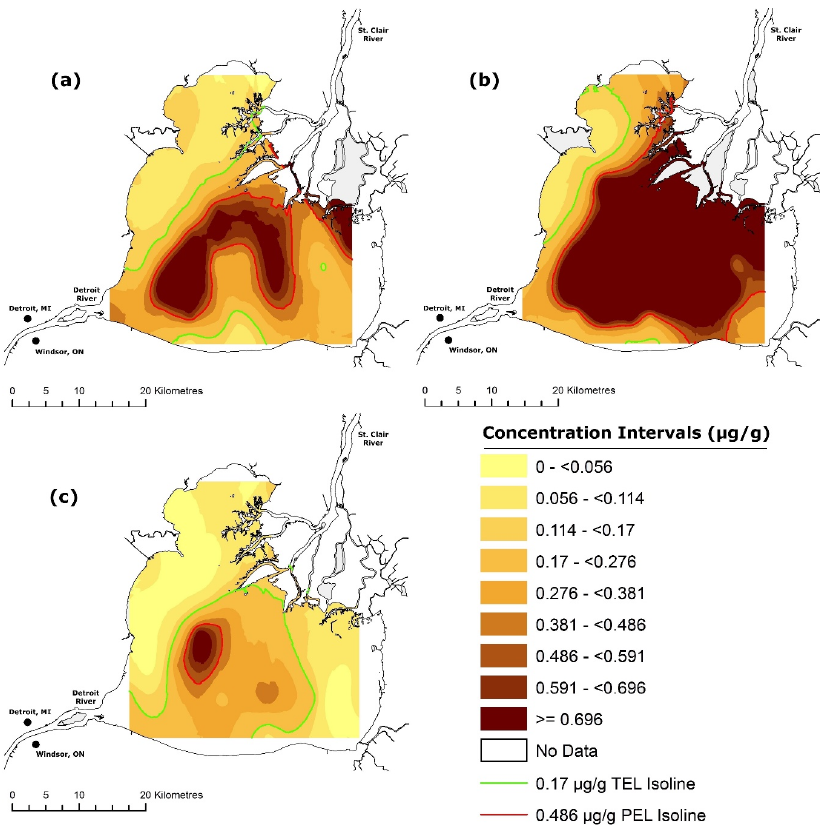
Figure 3. Two ‐ dimensional interpolated kriging distribution maps: ( a ) 1970; ( b ) 1974; ( c ) 2001.